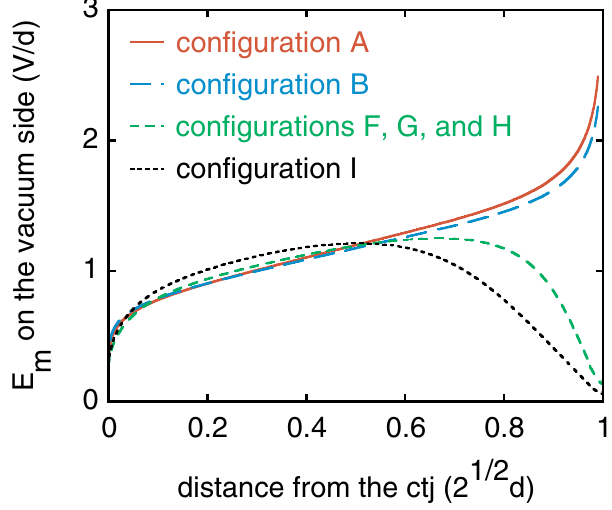
FIG. 13. (Color) The absolute value of the electric-field magni- on the vacuum side of the vacuum-insulator interface, as tude E m a function of distance along the interface, for 6 of the 9 configurations listed in Table II. (The fields for configurations FIG. 12. (Color) The absolute value of the electric-field magni- C and D are similar to that of B, except that the C and D fields as a function of position for the axisymmetric insulator- tude E are somewhat lower near the cathode triple junction. The field m electrode configuration of Figs. 10 and 11. The field assumes that for configuration E is similar to that of F, G, and H, except that the dielectric constant of the insulator " (cid:8) 2 : 55 . The color the field for E is somewhat higher near the cathode junction.) legend is a linear scale. The field is given in units of V=d , where The fields are given in units of V=d , where V is the voltage V is the voltage across the insulator and d is the insulator across the insulator and d is the insulator thickness as defined by thickness as defined by Fig. 1. The field plotted does not include Fig. 1. The distance from the ctj is given in units of 2 1 = 2 d , which effects due to the O-ring grooves shown in Figs. 10 and 11. A is the total length of the vacuum-insulator calculation with the grooves included shows that they change the at the vacuum-insulator interface by 1%, peak value of E m and that the field very near the sharp corners of the grooves are on the order of 3 V=d . This assumes that the grooves are completely filled with ethylene propylene ( " (cid:8) 2 : 6 ), the O-ring material.